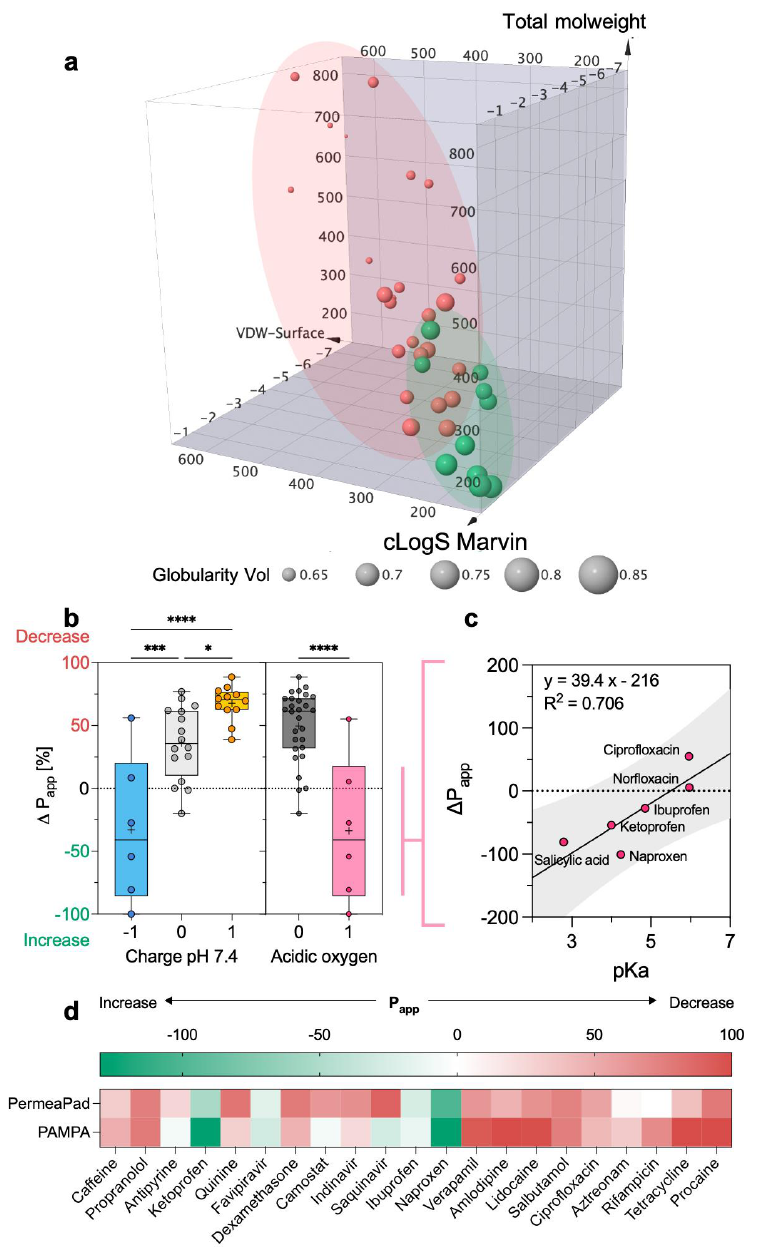
2 Figure 6. The effect of mucus and how it relates to the physicochemical properties of drugs. ( a ) Three-dimensional plot depicting the chemical space of the dataset as defined by cLogS, MW, and VDW Surface. The marker is sized by globularity volume. A binary color code is used to distinguish between high- (green) and low- (red) permeability compounds. ( b ) Box plot representation of charge at pH 7.4 and number of acidic oxygens versus the variation of permeability ( ∆ P app ) caused by mucus. Medians are represented as black horizontal lines, while the mean is represented as a plus symbol. ( c ) The xy plot of the relationship between pKa and the variation of permeability caused by mucus. The gray area represents the prediction bands using a 90% confidence level. ( d ) Comparison between the ∆ P app obtained on PermeaPad and PAMPA 96-well plates. PAMPA data are retrieved from [26] (* p < 0.05, *** p < 0.001, **** p <